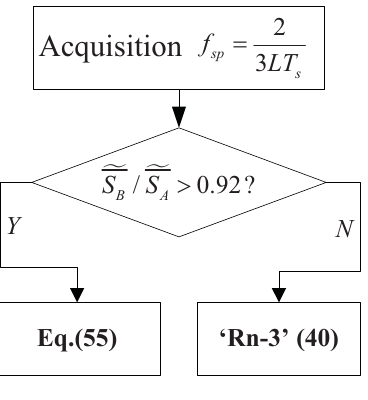
Figure 13. The strategy used in improved algorithm R n